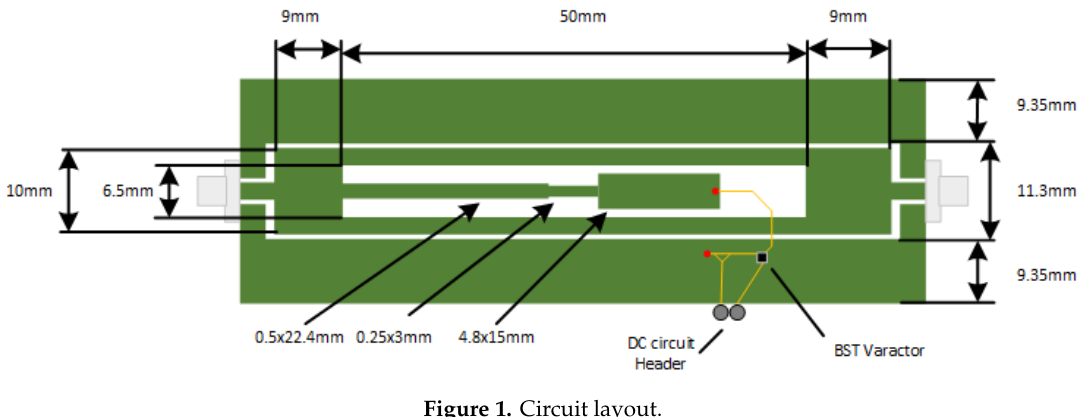
Figure 1. Circuit layout.